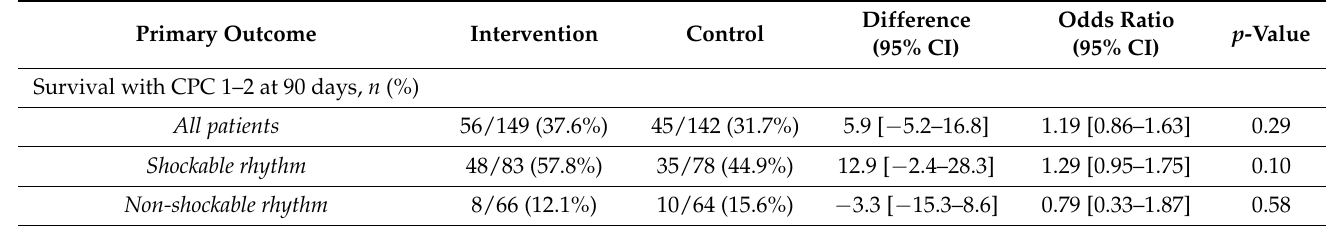
(Table 3). In the random effects model analysis, the OR was 1.13 [95% CI, 0.63–2.07]; p = 0.55). Table 3. Primary outcome in the study population, which are presented as odds ratio (OR) and 95% confidence intervals (CI). Data are presented in all patients and in the subgroup of patients with shockable (ventricular fibrillation or pulseless ventricular tachycardia) and non-shockable (asystole and pulseless electric activity) initial rhythm. CPC = Cerebral Performance Category.